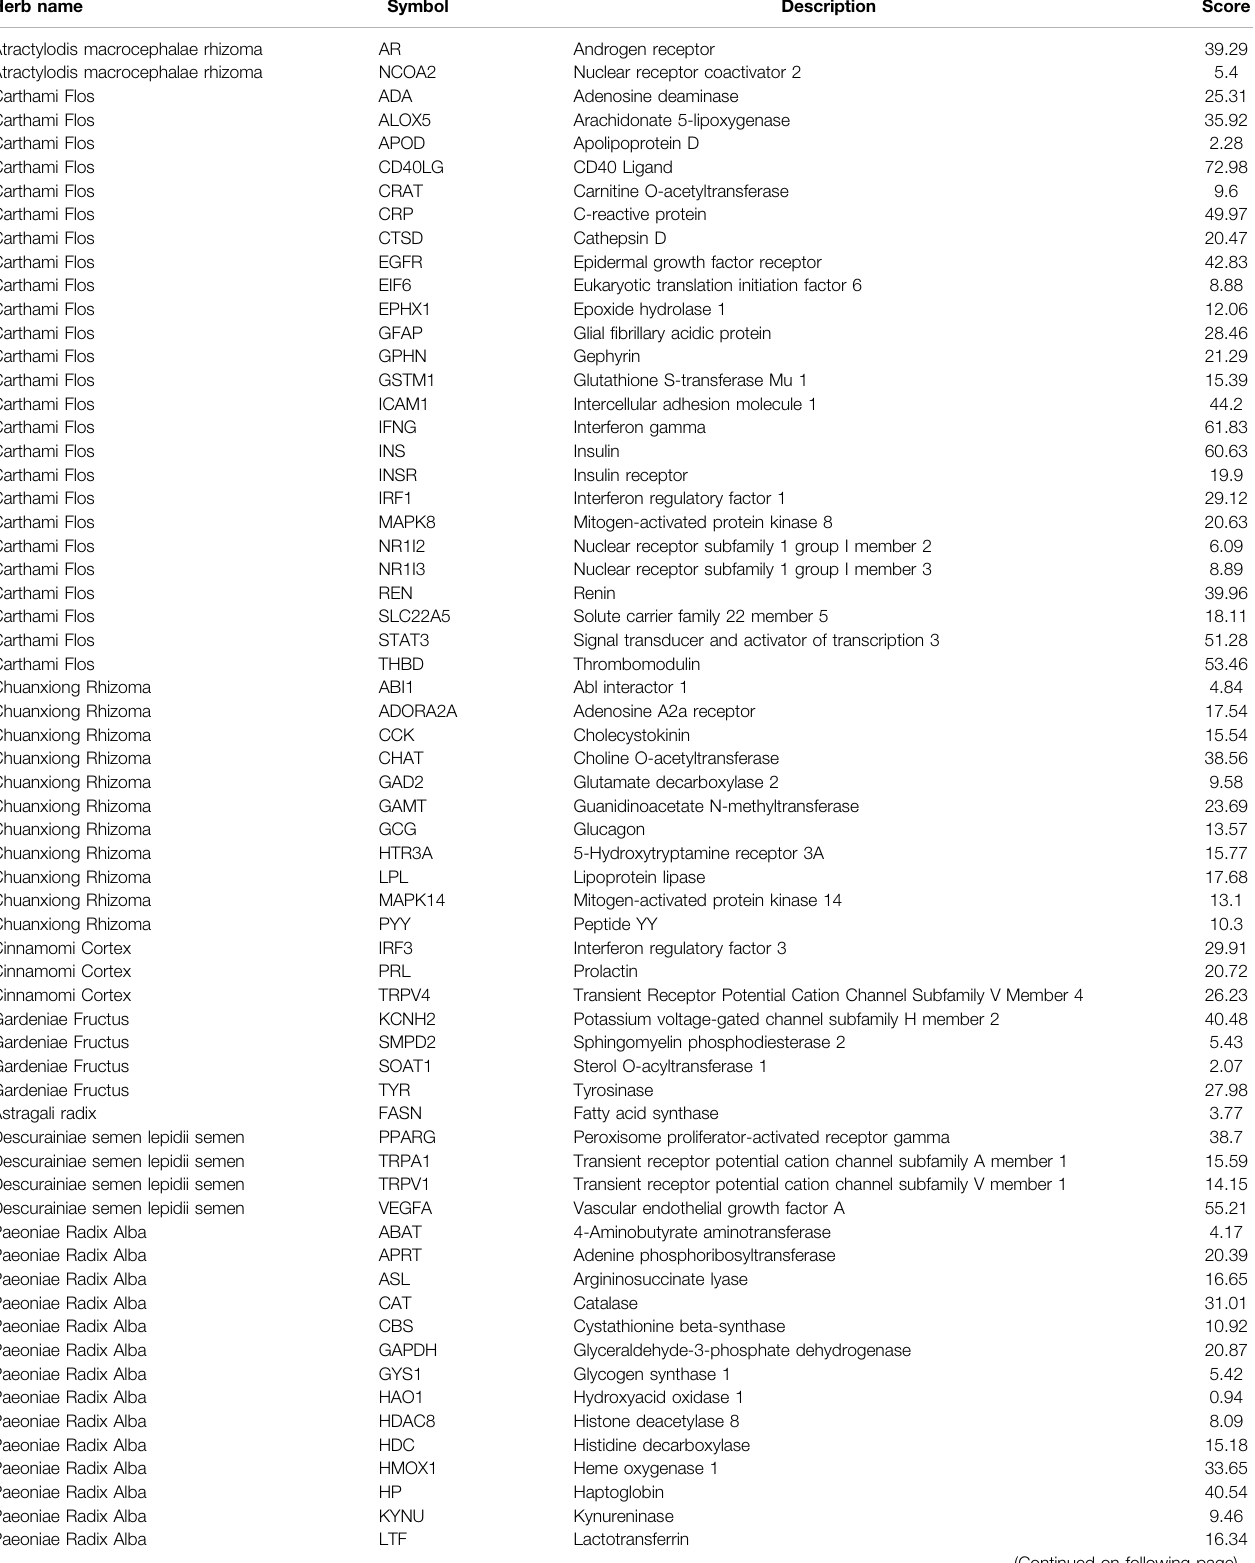
TABLE 2 | Targets of NFPX on ARDS were screened by network pharmacology analysis. Herb